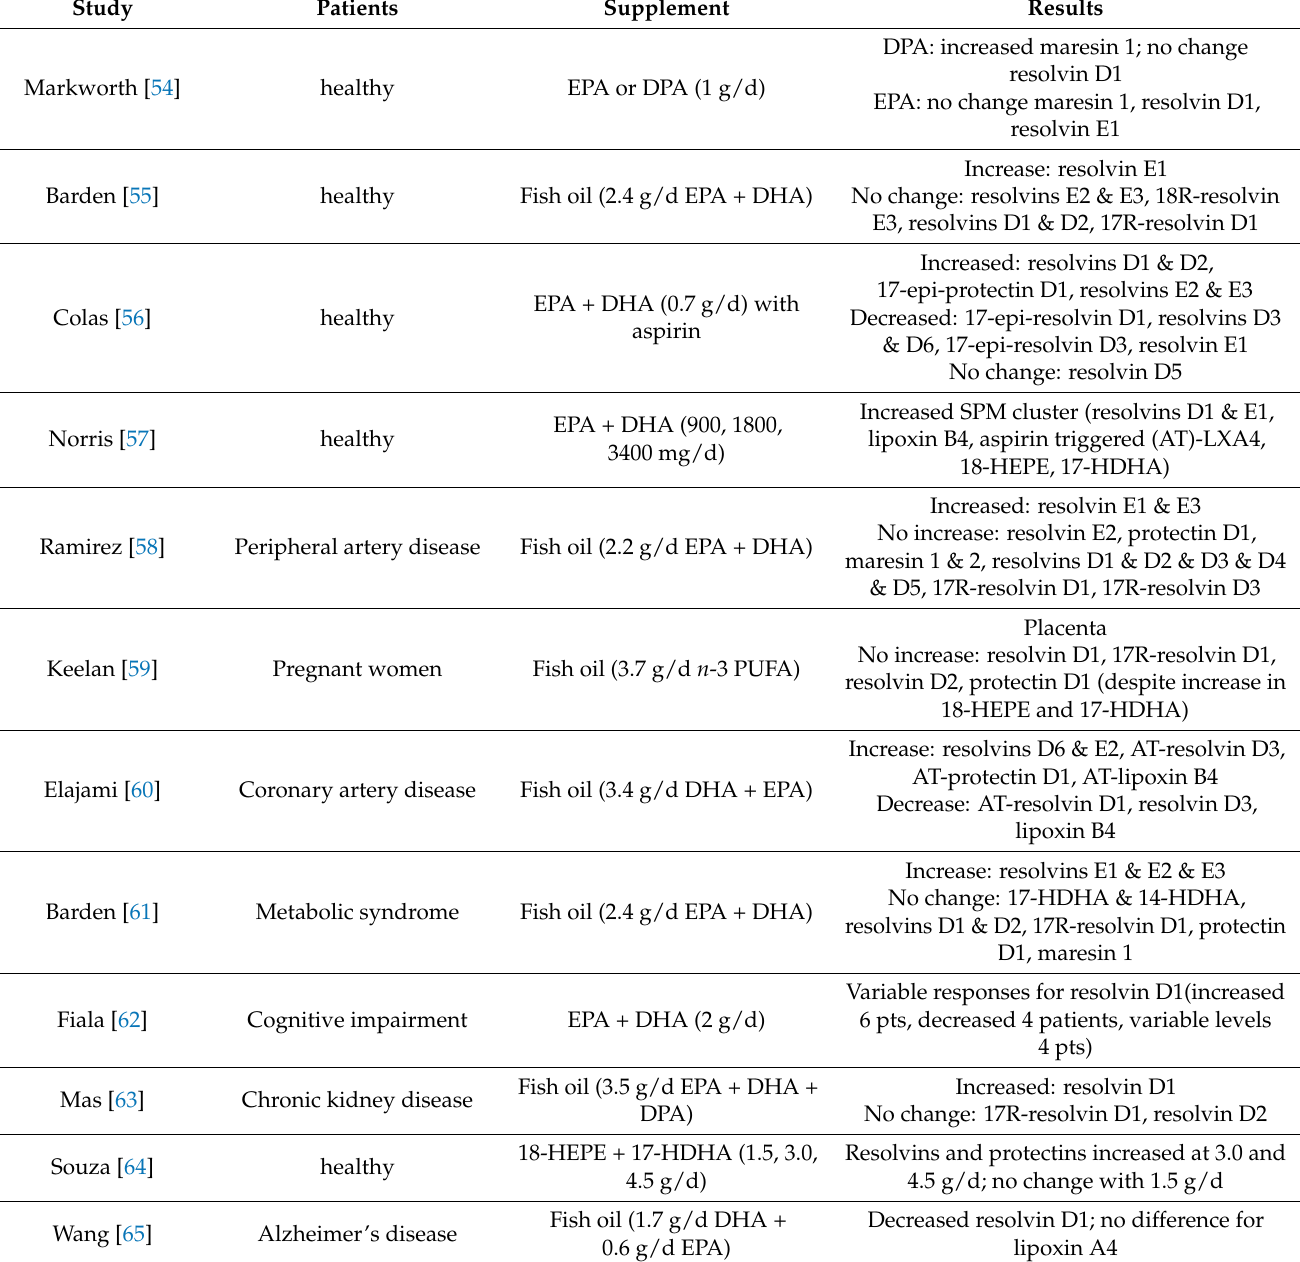
Table 3. Effect of n -3 PUFA Supplementation upon Levels of Resolution